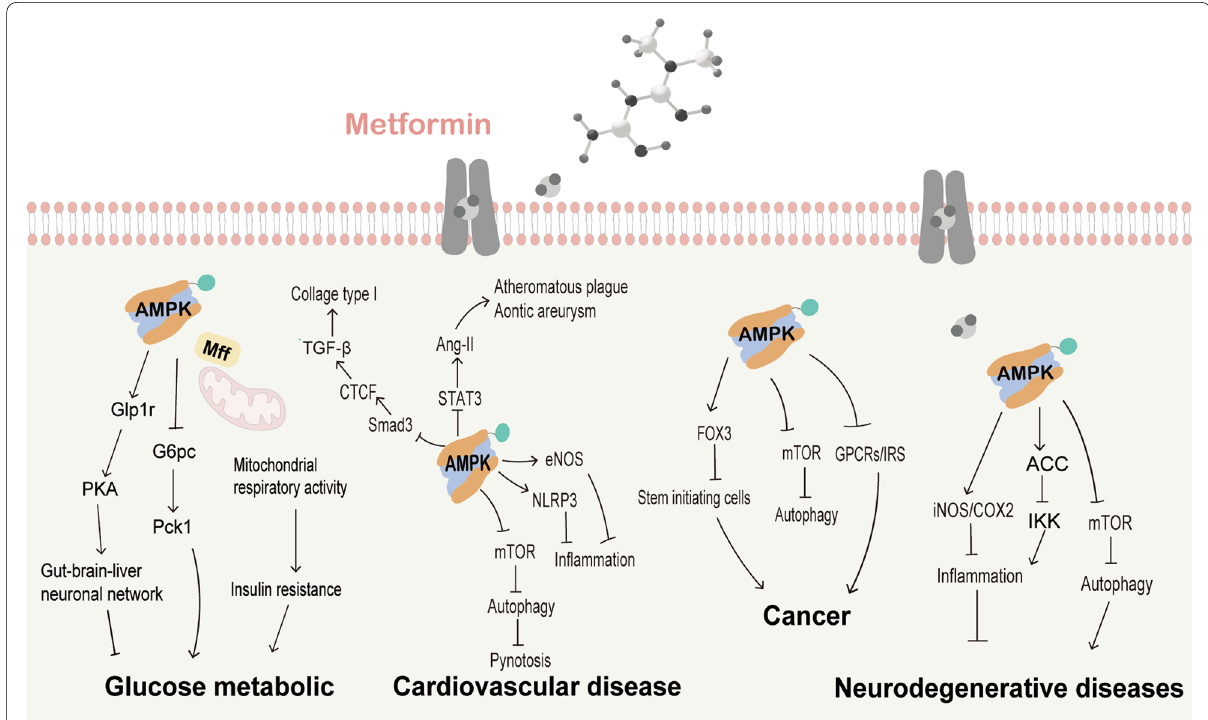
Fig. 2 AMPK‑dependent mechanism of action mediated by metformin treatment. Depending on AMPK activation, metformin exerts its effects by regulating Glp1r/Pka pathway, mTOR/autophagy pathway, NLRP3, eNOS, STAT3,COX‑2, iNOS, Smad3, FOX3, IRS, GCRP and PD‑L1 and ACE2